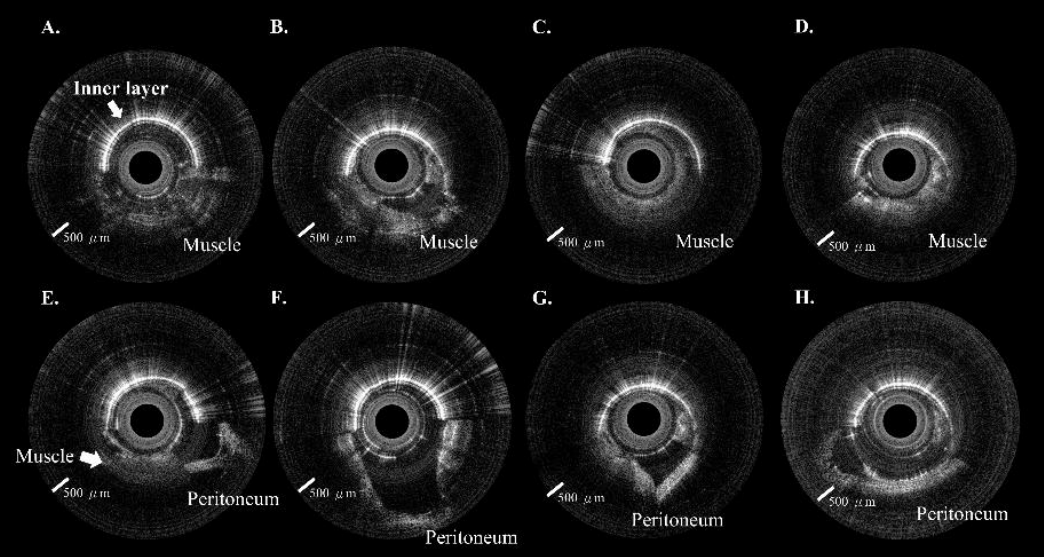
Figure 5. Veress needle probe punctured the paramedian region of the belly. ( A – D ) Around half of the OCT image shows the extra-peritoneal tissue. ( E – H ) Around half of the OCT image shows the peritoneum. Table 1. SSOCT criteria for identifying muscle, fascia, peritoneum, and intraperitoneal tissue.